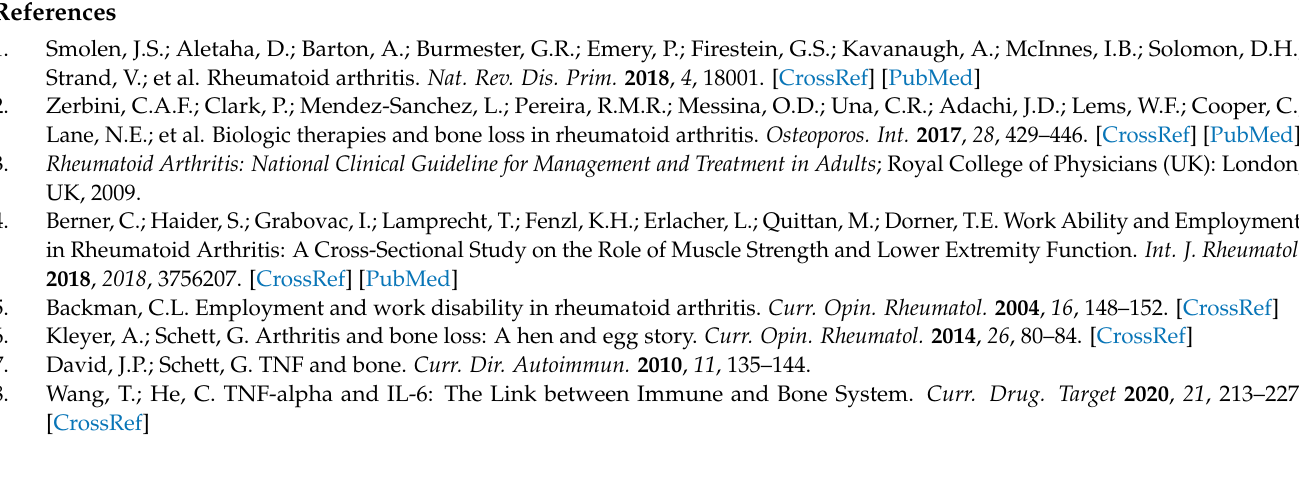
Table S2: Antibodies used for FACS analysis. Table S3: Primers used for real-time